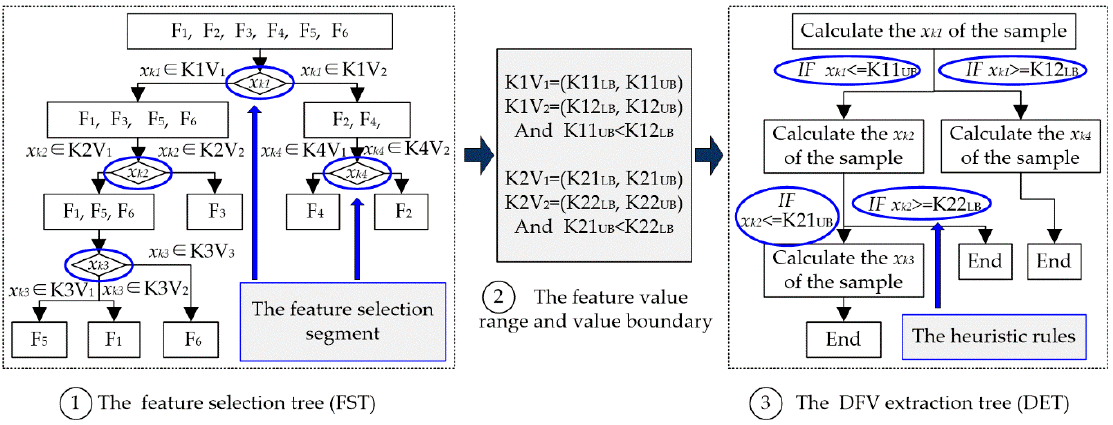
Figure 5. DFV extraction based on the DFV extraction tree.